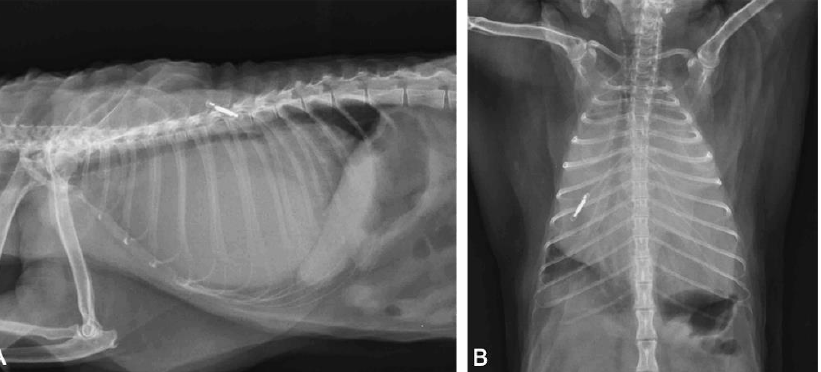
Figure 1. Thoracic radiographs (( A ): right-lateral view; ( B ): ventro-dorsal view). The cardiac silhou- ette appears severely enlarged, causing dorsal displacement of the trachea and lung and diaphrag- matic compression. The microchip transponder is on the left side.